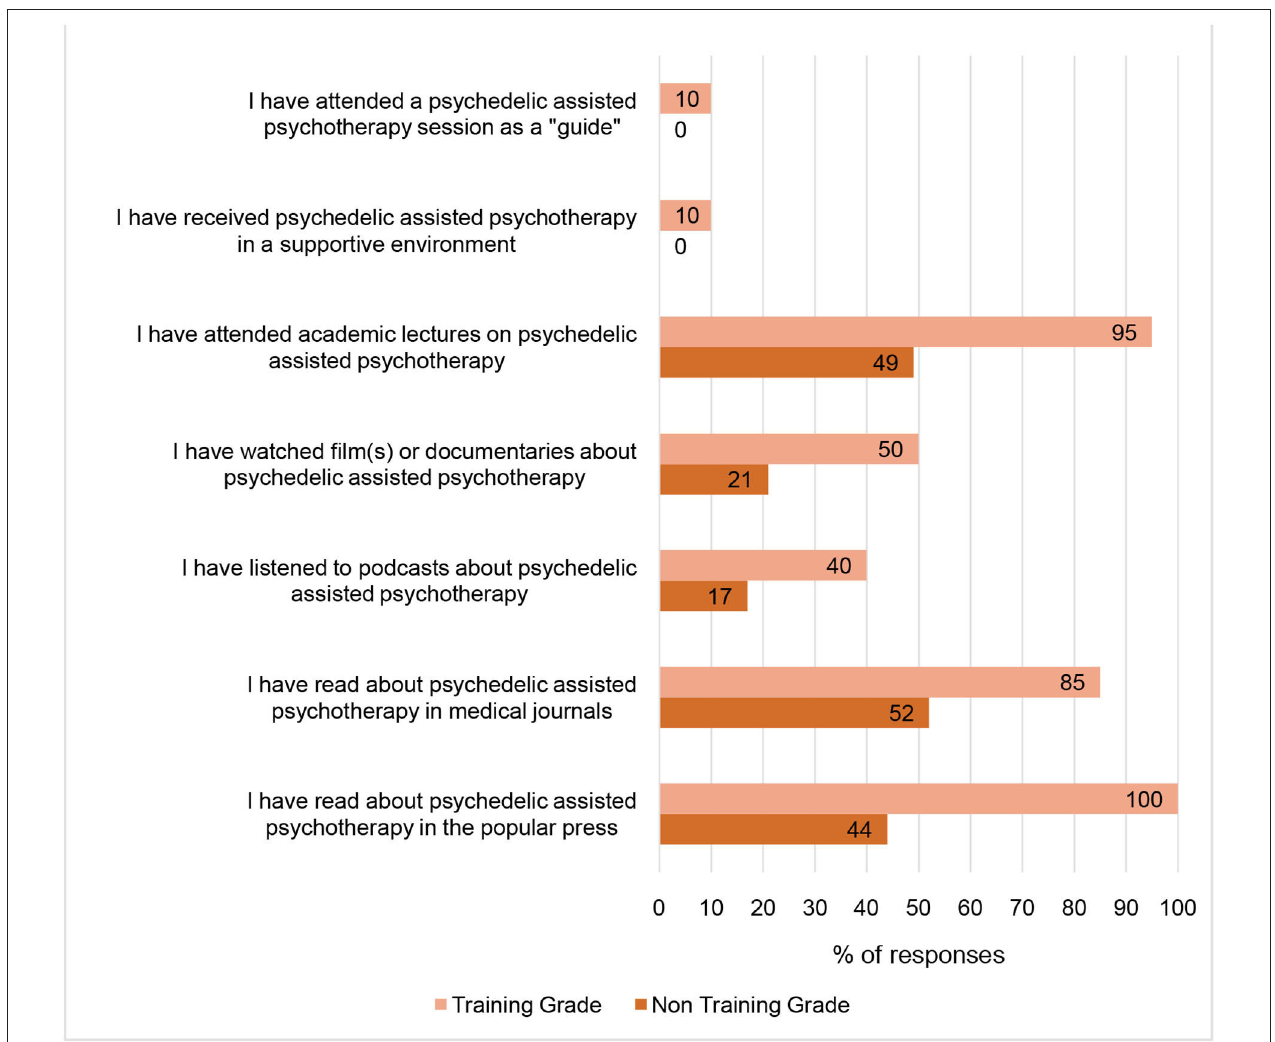
FIGURE 1 | Exposure of psychiatrists to Psychedelic-Assisted Psychotherapy. This figure shows the proportion (%) of psychiatrists who have been exposed to PAP and through which mediums. Total number of responses = 83; Training grade psychiatrists = 20; Non-training grade psychiatrists =